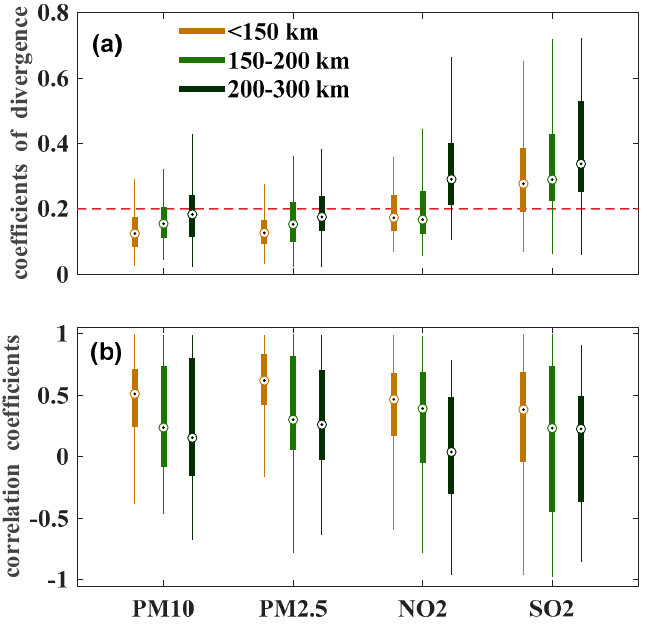
Figure 8. Overall inter-site CODs ( a ) and R ( b ) of SO 2 , NO 2 , O 3 , PM 10 , PM 2.5 and CO in different buffers during the intensive burning period.